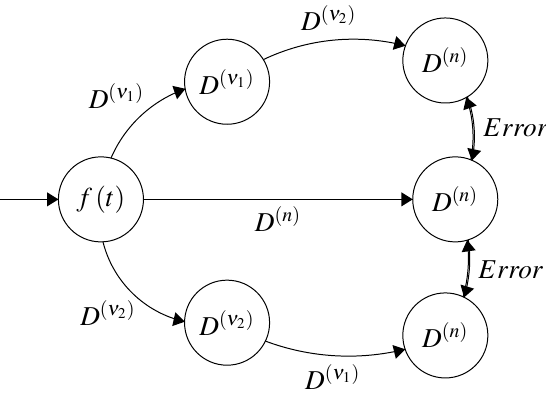
Fig. 3 Two fractional orders ν 1 and ν 2 of different values concatenated to obtain an integer order n , i.e. ν 1 + ν 2 = n .